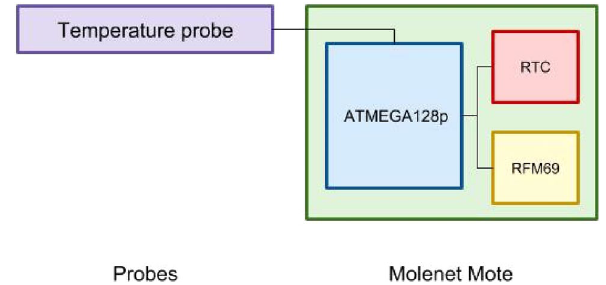
Fig. 5 Architecture of the temperature-only node